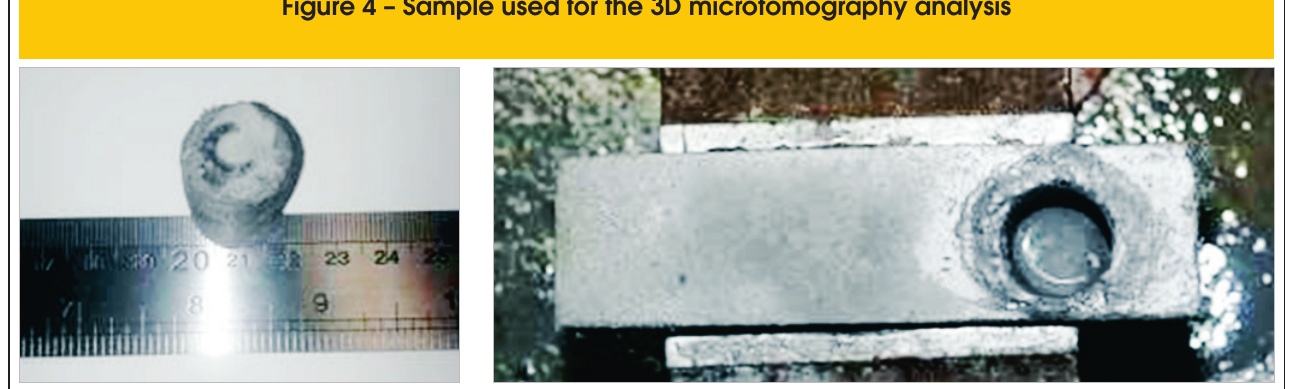
Figure 4 – Sample used for the 3D microtomography